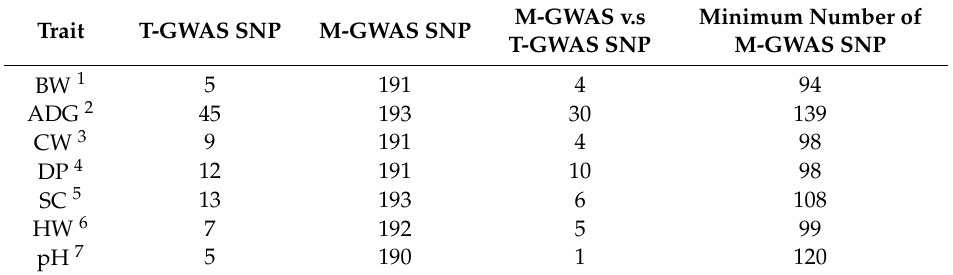
Table 4. Number of associated markers both in traditional and multivariate GWAS and in common markers (T-GWAS and M-GWAS, respectively). The minimum number of discriminant SNPs in the multivariate approach are also displayed.